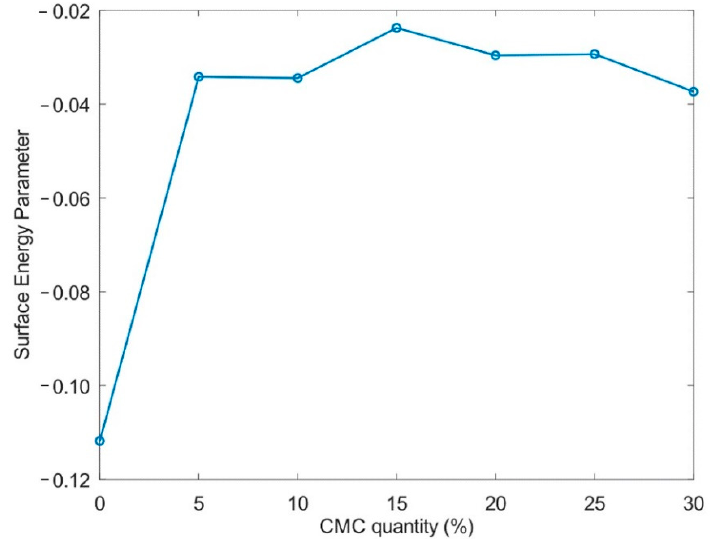
Figure 4. E surf energy surface parameter as a function of the amount of CMC. This parameter shows the difference in energy interaction between the water molecules and the materials of different CMC contents. Upon adding the CMC, an initial increase in this parameter was detected, indicating a stronger interaction.